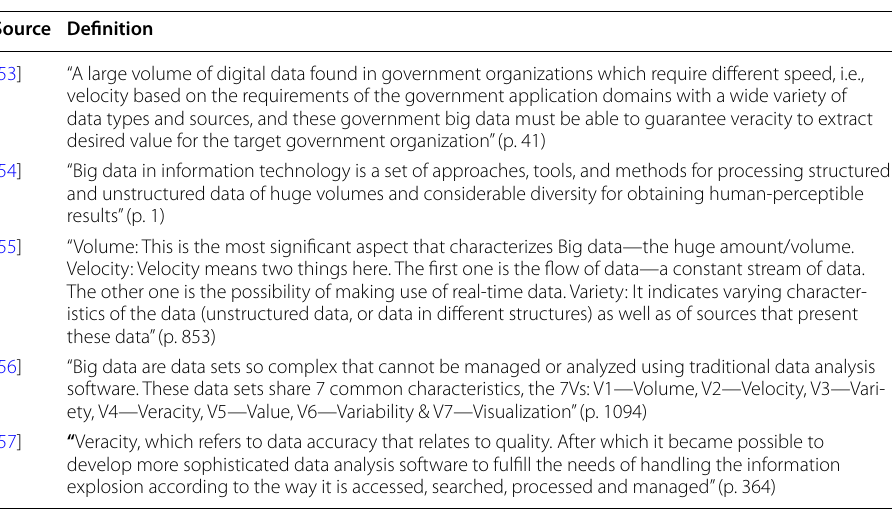
Table 8 Big data